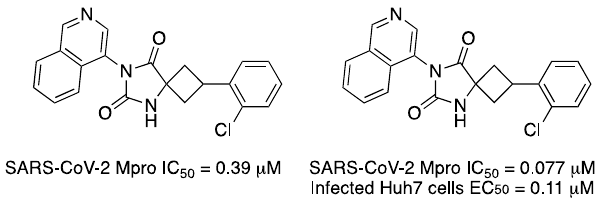
Figure 11. SARS ‐ CoV ‐ 2 Mpro inhibitors with a hydantoin scaffold.